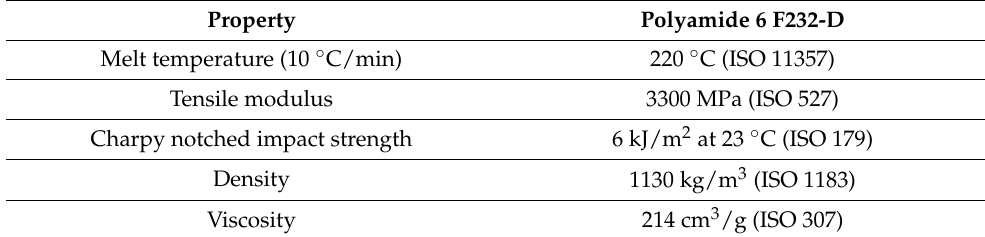
Figure 1. Molecular structure of PA6. Table 1. Properties of pure materials.